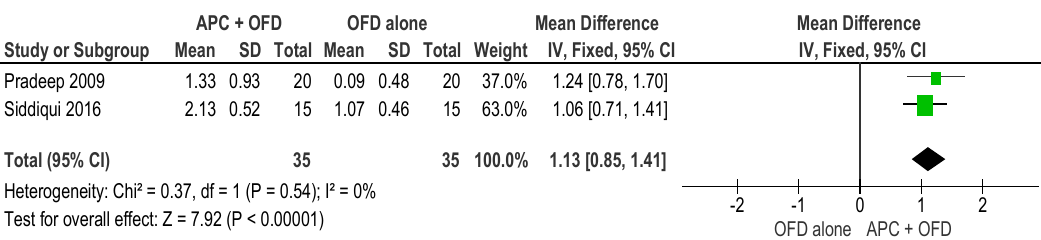
Figure 11. Forest plot showing the effect on horizontal furcation length for comparison of APC + OFD versus OFD alone at end of all-follow-up (6–12 m).